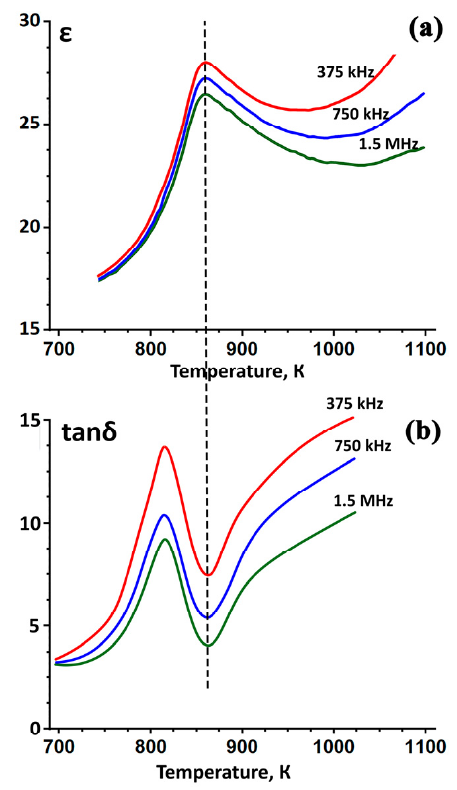
Figure 4. Temperature dependence of the dielectric permittivity ε ( a ) and dielectric loss tangent tan δ ( b ) for Ca 9 Gd(PO 4 ) 7 .